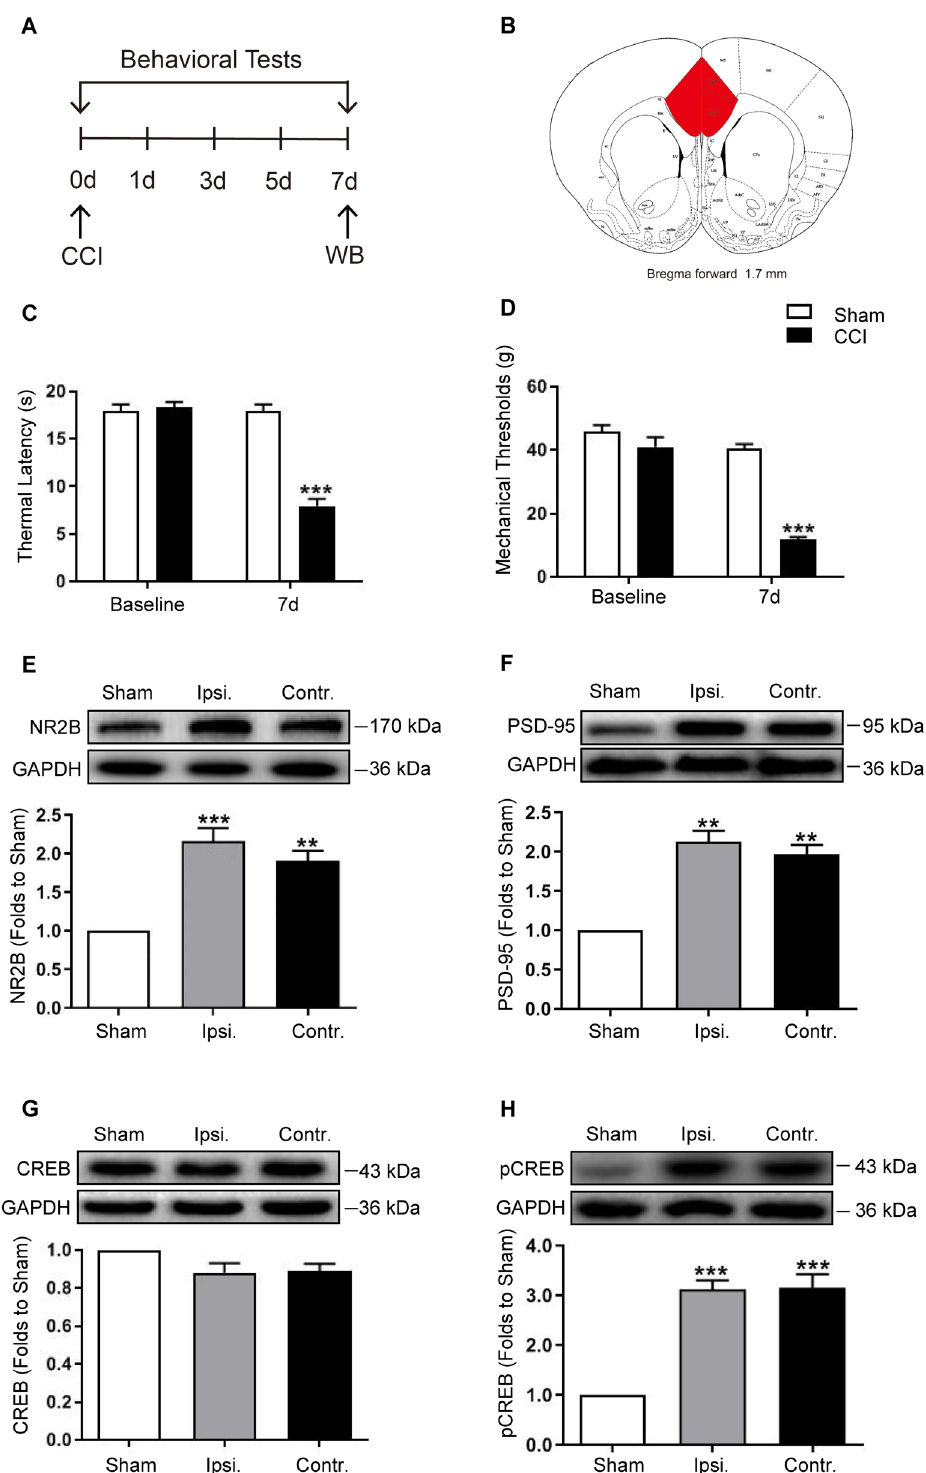
Figure 2. CCI-induced behavioral hypersensitivity, NR2B/PSD-95 upregulation, and CREB activation in the ACC. ( A ) Schematic diagram of the experiment. ( B ) The anatomical boundaries used for ACC tissue harvest. In comparison with the sham group, the CCI group showed significantly lower thermal latency ( C ) and mechanical threshold ( D ) on the 7th day after surgery (*** P < 0.001, independent t- test, n = 6). Western blot showing that compared to that in the sham group, the expression of NR2B ( E ) and PSD-95 ( F ) in the ACC was bilaterally increased in the CCI group (*** P < 0.001, ** P < 0.01, vs. Sham, one- way ANOVA, n = 4); while the total CREB ( G ) did not change, the level of pCREB ( H ) was bilaterally increased in the CCI group (*** P < 0.001, vs. Sham, one-way ANOVA, n = 4). GAPDH was loading control and error bars represent standard error of the mean (SEM). Original images of blots are available in supplementary Fig. S2. ACC: anterior cingulate cortex; CCI: chronic constriction injury; Ipsi: Ipsilateral; Contr: Contralateral; NR2B: NMDA receptor subunit 2B; CREB: Cyclic AMP response element-binding protein; pCREB: phosphorylated CREB; GAPDH: glyceraldehyde-3-phosphate